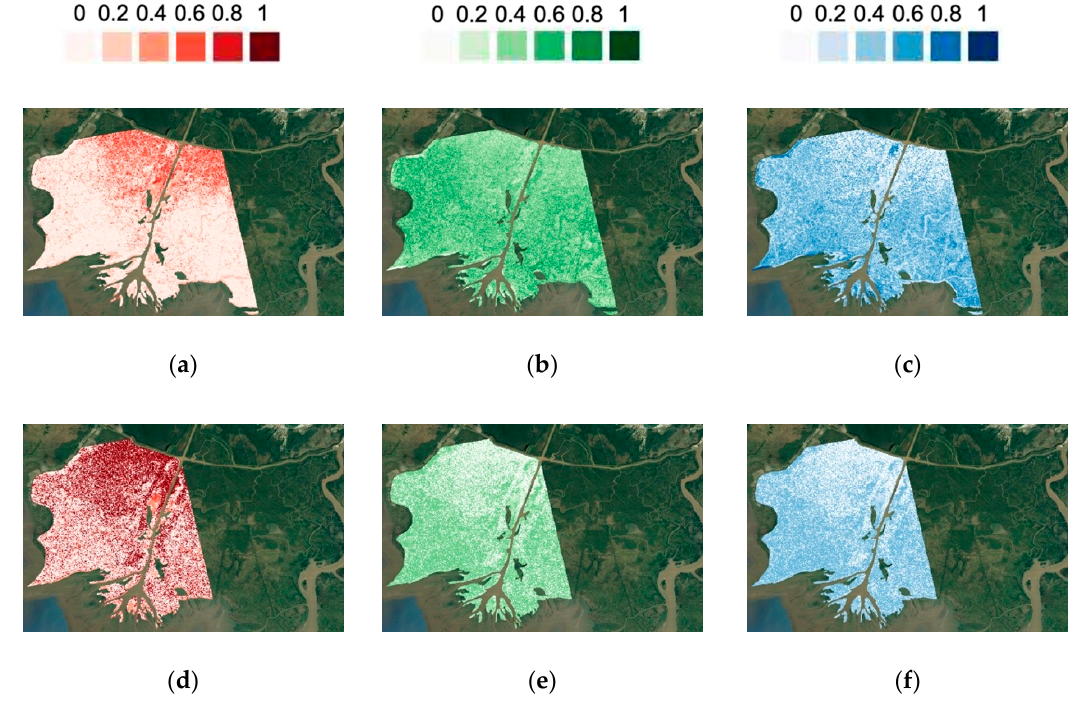
Figure 10. Double bounce ( f D ), volume ( f V ), and surface scattering ( f S ) from non-negative eigenvalue decomposition (NNED) decomposition: ( a ) f D ( 2011.4.3), ( b ) f V (2011.4.3), ( c ) f S ( 2011.4.3), ( d ) f D (2009.11.13), ( e ) f V (2009.11.13), and ( f ) f S (2009.11.13). (Background Map from Google